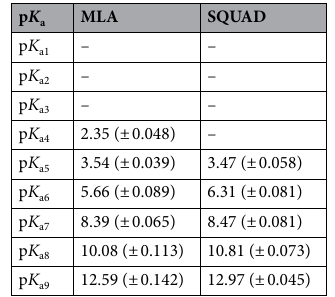
Table 1. The computed p K a values of MTB by the MLA and those reported previously using stability quotients from absorbance data (SQUAD) program 62 . Numbers in parentheses indicate the standard error ( σ P ) values on acidity constants.